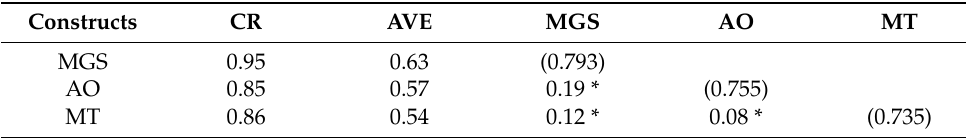
Table 3. Convergent and Discriminant Validity of MGS, AO, and AO